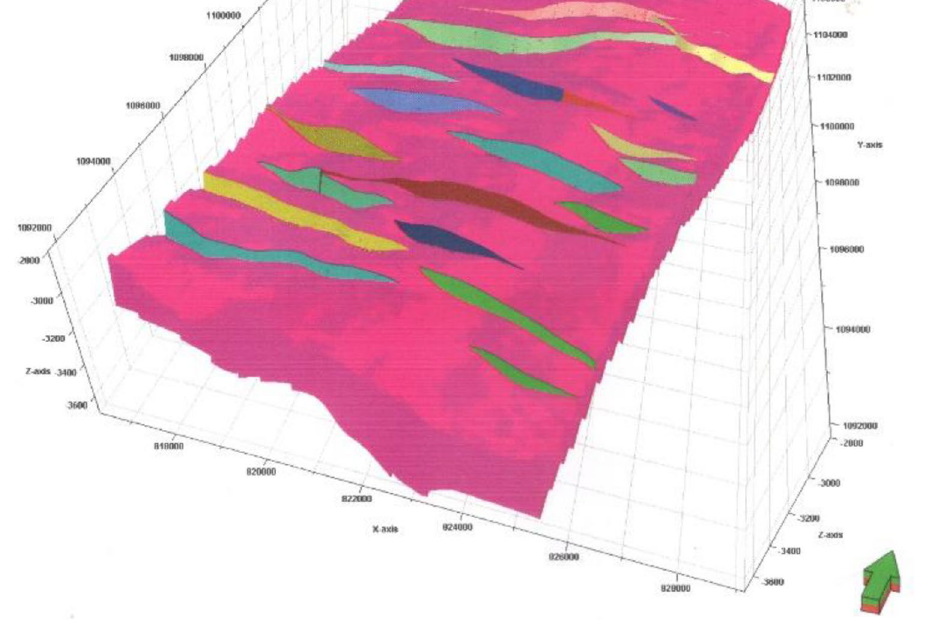
Fig. 13 Structural model of Upper Oligocene X